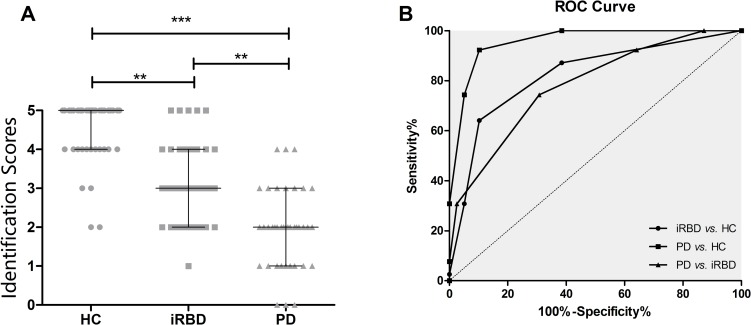
Differentiation among HC, iRBD and PD patients by the brief test in validation.(A) Scatterplots of individual scores with the respective group median and 25th and 75th percentiles for the brief test in validation. (B) Receiver Operating Characteristic (ROC) curves showing the relationship between the sensitivity and specificity of the brief test in validation. ***P<0.001, **P<0.01